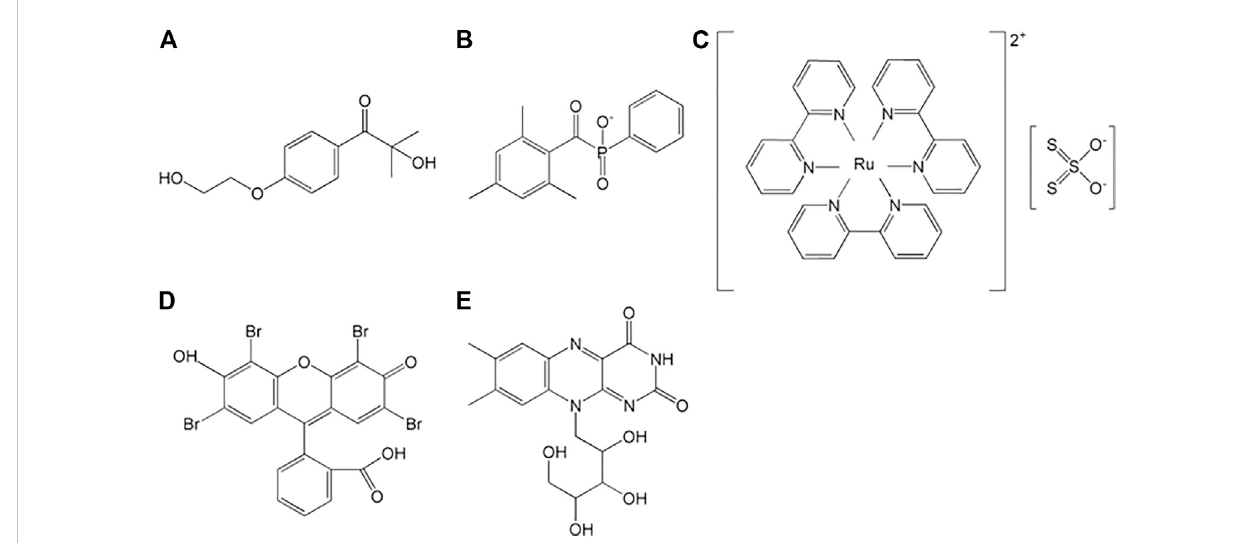
FIGURE 3 Commonphotoinitiators: (A) Irgacure2959, (B) lithiumphenyl-2,4,6-trimethylbenzoylphosphinate, (C) ruthenium( Ⅱ )/persulfate, (D) eosinY,and (E) ribo fl avin (Mu et al.,